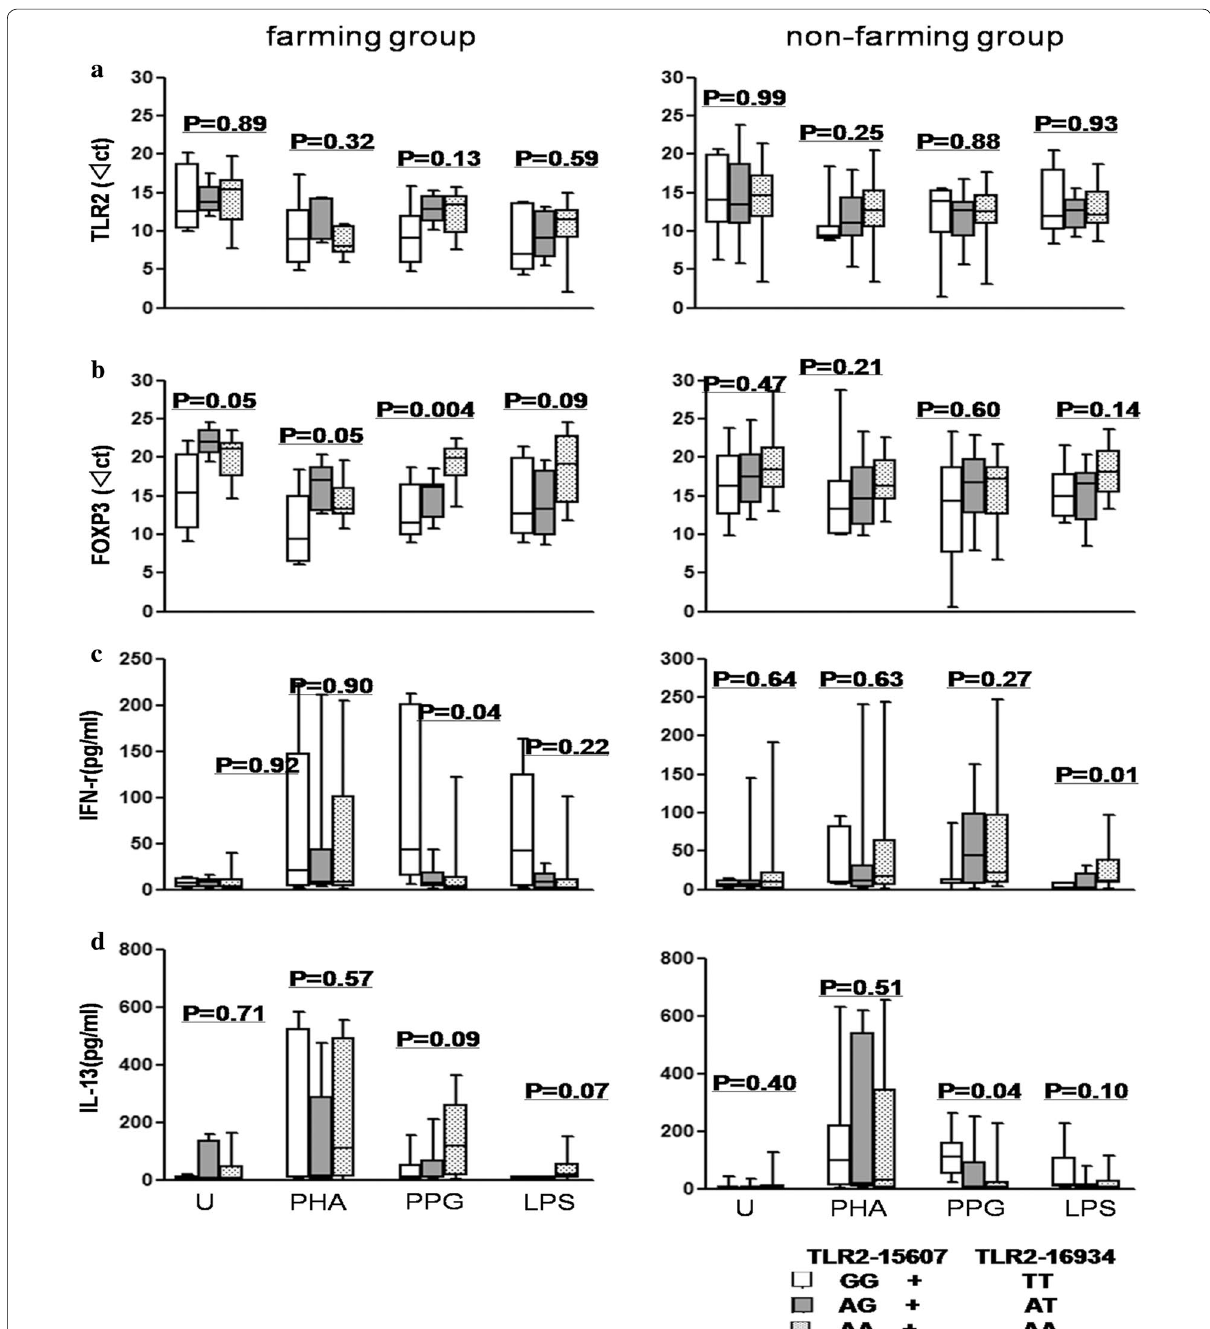
Fig. 7 Association of TLR2 SNPs (TLR2-15607, TLR2-16934) with FOXP3 gene expression, and IFN-γ and IL-13 production. a TLR2 gene expression; b FOXP3 gene expression; c IFN-γ production; d IL-13 production. The values are represented as median (25%/75% IQR). Kruskal–Wallis test was performed to analyze three groups with alleles of GG TT (TLR2-15607 GG TLR2-16934 TT), AG AT (TLR2-15607 AG TLR2-16934 AT), and + + + + AA AA (TLR2-15607 AA TLR2-16934 AA). n 40 in farming group, n 80 in non-farming + + = =